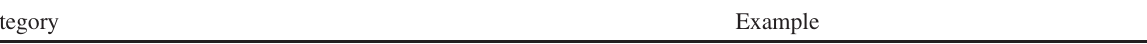
TABLE II. Prior beliefs exhibited in essays.